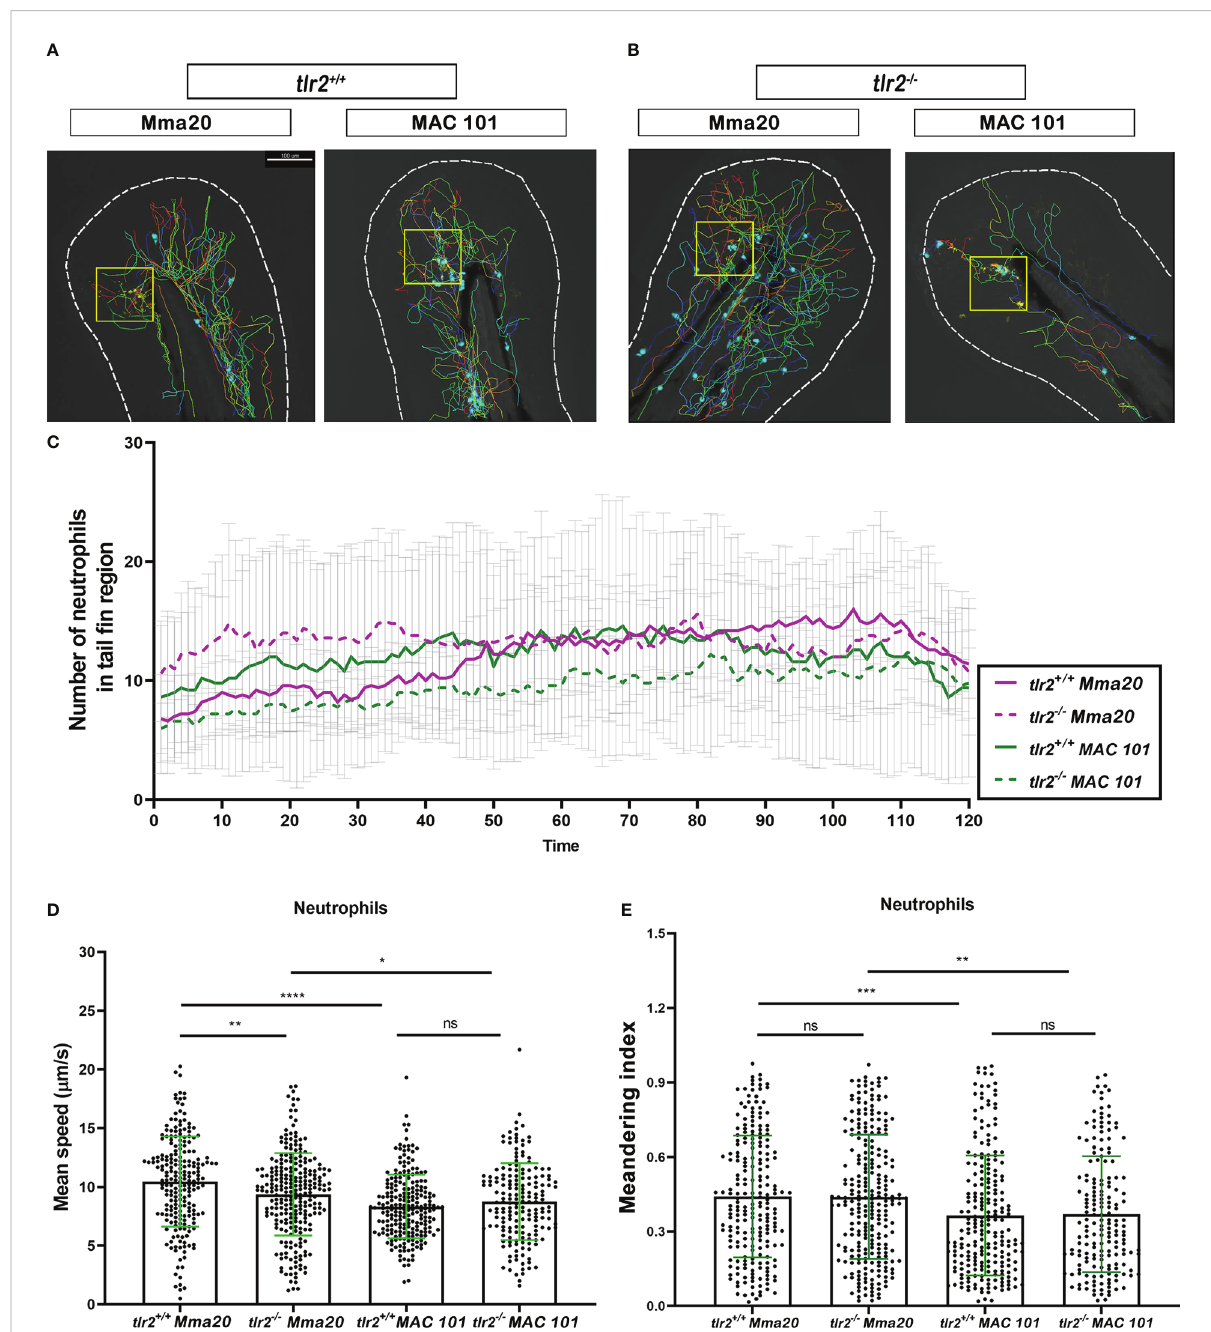
FIGURE 4 Quanti fi cation of neutrophils behavior in tlr2 mutant and wild type control larvae after M. marinum Mma20 or M. avium MAC 101 tail fi n infection. (A, B) Representative images of neutrophil tracks in tlr2 +/+ or tlr2 -/- larvae with Mma20 or MAC 101 tail fi n infected. The cyan balls represent the tracked neutrophils, the yellow box indicates the infected area. (C) The number of recruited neutrophils to the tail fi n region upon Mma20 or MAC 101 infection. The curves represent the mean value of the recruited neutrophil numbers at different time points. (D) The mean speed of individual tracked neutrophils in the tail fi n region. (E) The meandering index of tracked neutrophils in the tail fi n region. In (D, E) data (mean ± SD) were combined from three independent experiments with 5 fi sh in each group. Two-way ANOVA with Tukey ’ s multiple comparison test as a post-hoc test. ns, non-signi fi cant; *P < 0.05, **P < 0.01, ***P < 0.001, ****P < 0.0001. Scale bar: 100 µm; Sample size (n): 217, 254, 228, 179 (D, E)